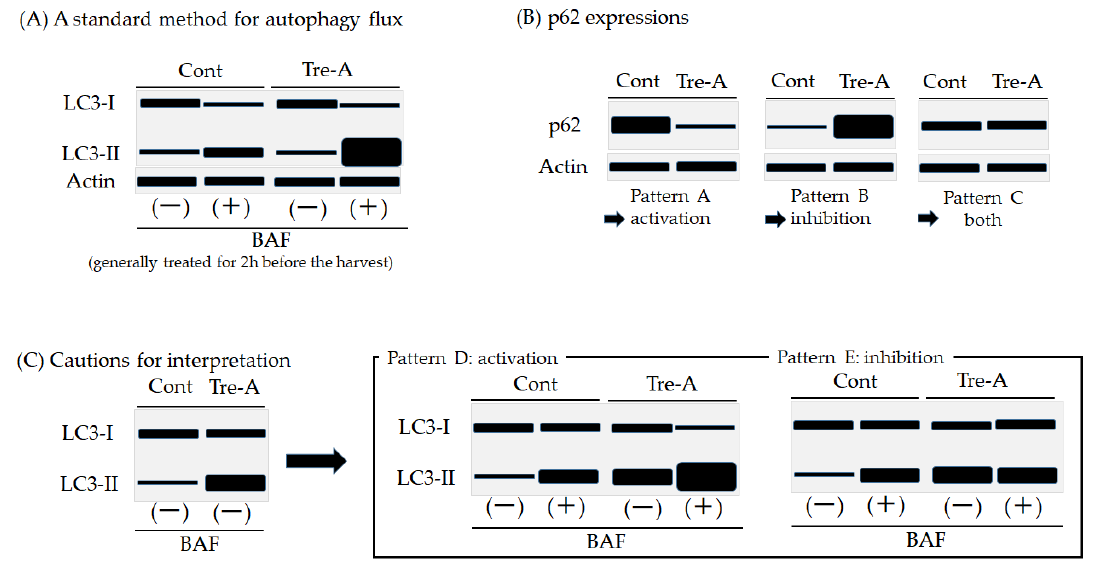
Figure 2. The methods for evaluating autophagy flux. ( A ) Treatment A (Tre-A) increases LC3-II protein in the presence of BAF. The ratio of LC3-II/Actin with BAF is higher in the Tre-A than control (Cont), indicating autophagy activation. ( B ) Examples of p62 expression with some treatment. Pattern A is a typical result that indicates autophagy activation by the treatment. Pattern B highly suggests autophagy inhibition because an autophagy receptor, p62, is accumulated. Pattern C can be seen in both statuses. ( C ) This result does not indicate autophagy activation by Tre-A. When autophagy flux is seen with BAF, autophagy is activated (pattern D). Meanwhile, LC3-II does not increase in the cells with Tre-A in the presence of BAF, indicating autophagy inhibition (pattern